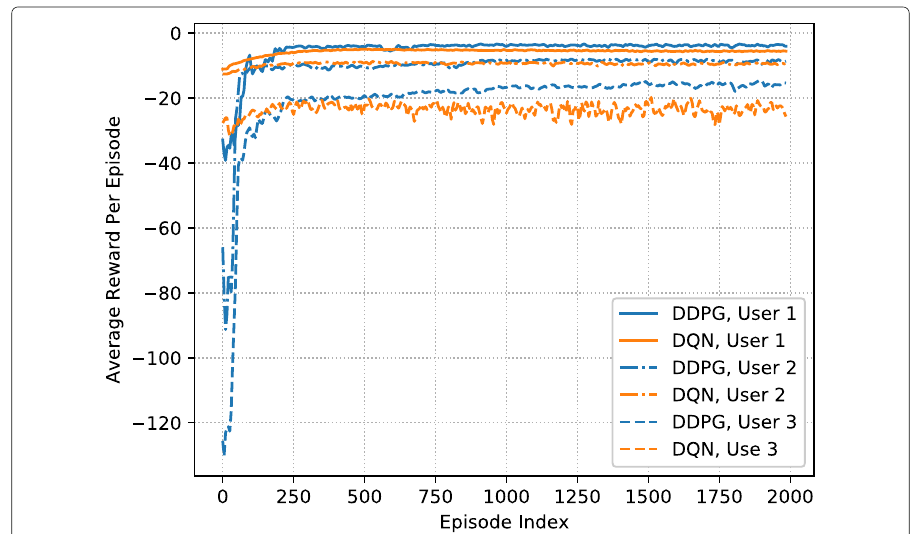
Fig. 9 Illustration of the average reward in the training process with w m = 0.5 for all mobile users